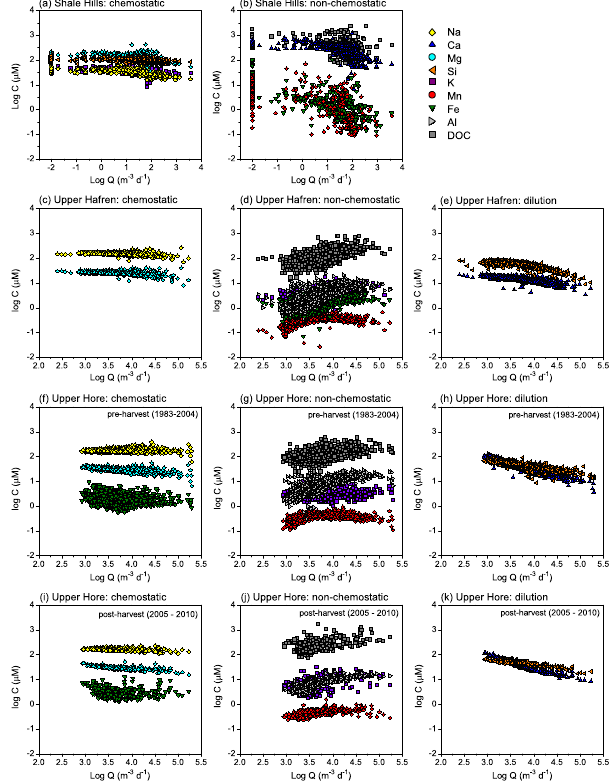
Figure 2. Log- C (solute concentration) versus log- Q (discharge) in the Shale Hills catchment (a, b) and two Plynlimon subcatchments, the Upper Hafren (c–e) and Upper Hore (f–h) . Data from the post- harvest period (2005–2010) in the Upper Hore are plotted in sepa- rate panels (i–k) . For each catchment, the left panel shows elements that exhibit chemostatic behavior, the middle panel shows non- chemostatic elements that exhibit behavior similar to DOC (e.g., dilution at Shale Hills and enrichment at Plynlimon), and the right panel shows elements that exhibit dilution